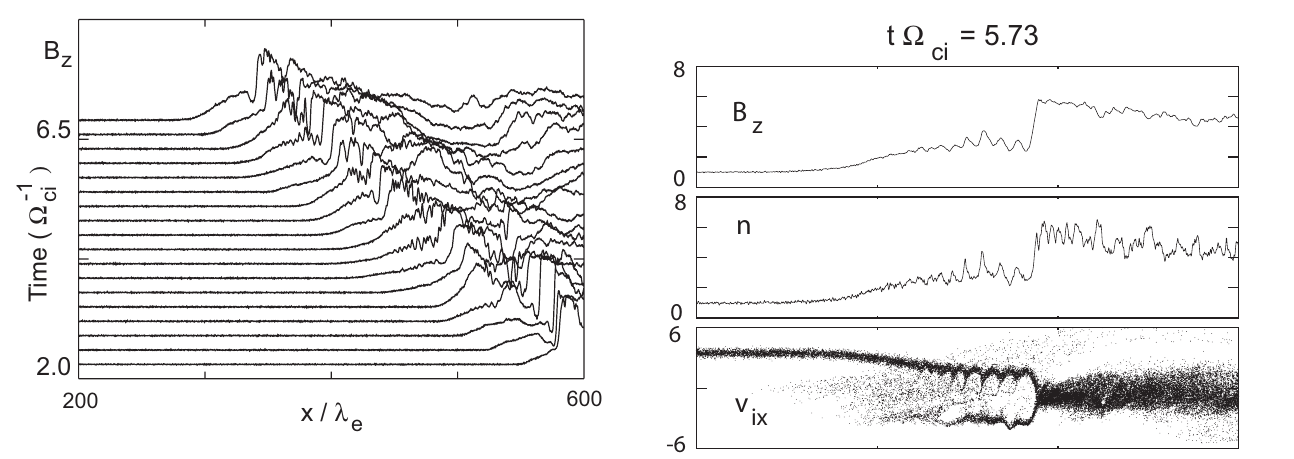
Fig. 1. Magnetic field B z component stacked in time for the ion to electron mass ratio 1024 run. Time runs from bottom to top.